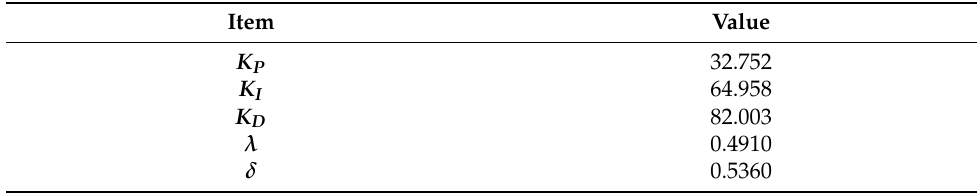
Table 6. Optimal values of the FOPID-PODC parameters for scenario 1.